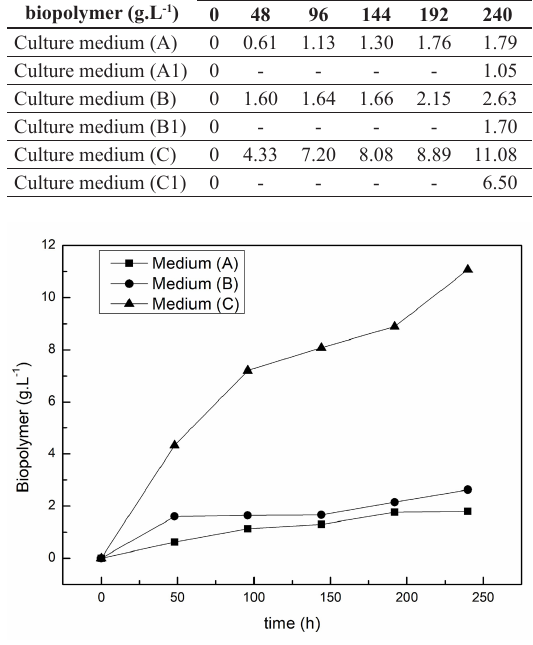
Figure 1. Production of bacterial cellulose as a function of the time for the culture media (A), (B) and